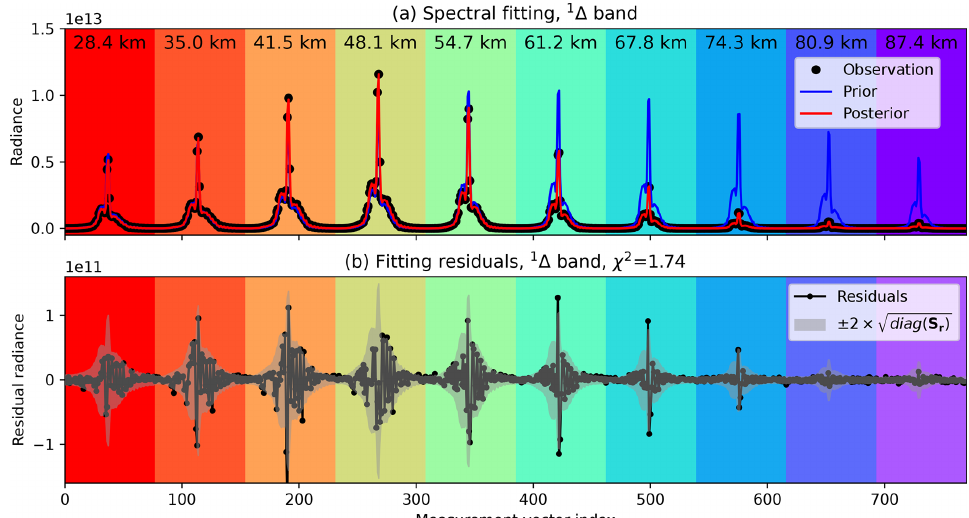
Figure 2. (a) SCIAMACHY limb-viewed spectra concatenated over 10 tangent heights within one vertical sounding (black), simulated concatenated spectra using the prior values of the state vector (blue), and simulated concatenated spectra using the posterior values of the state vector (red). Each limb-viewed 1 (cid:49) -band spectrum contains 77 data points, so the measurement vector length is 770. Altitudes of each tangent height are labeled above the corresponding spectra. The radiance unit is photonscm − 2 s − 1 nm − 1 sr − 1 . (b) Residuals from the fit in panel (a) and the 95% confidence intervals of residuals are shown.